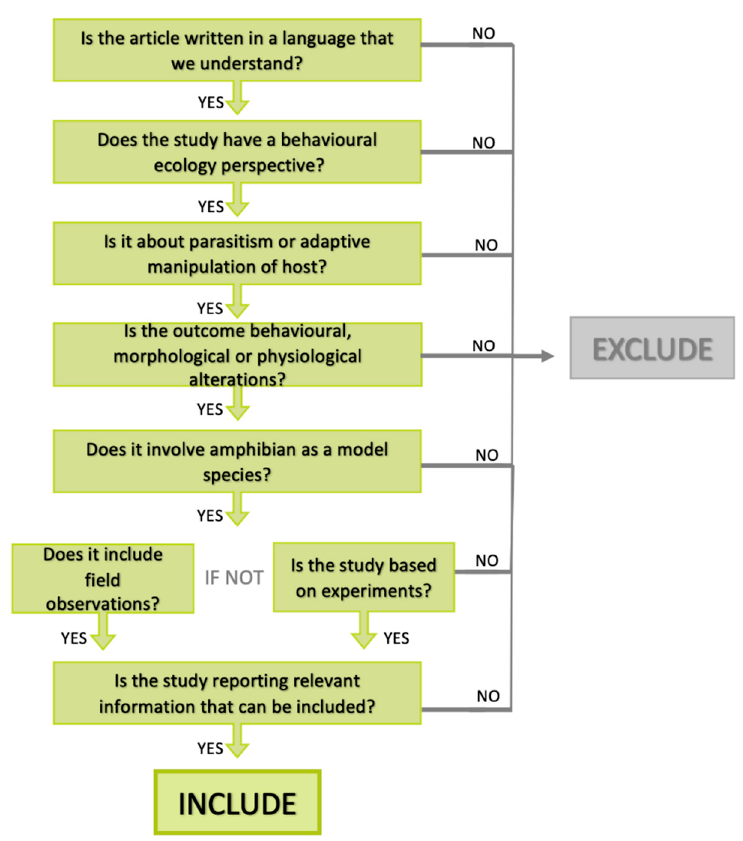
Figure 1. PRISMA flow diagram showing inclusion and exclusion criteria adapted for systematic review on parasitism and adaptive manipulation in amphibians.